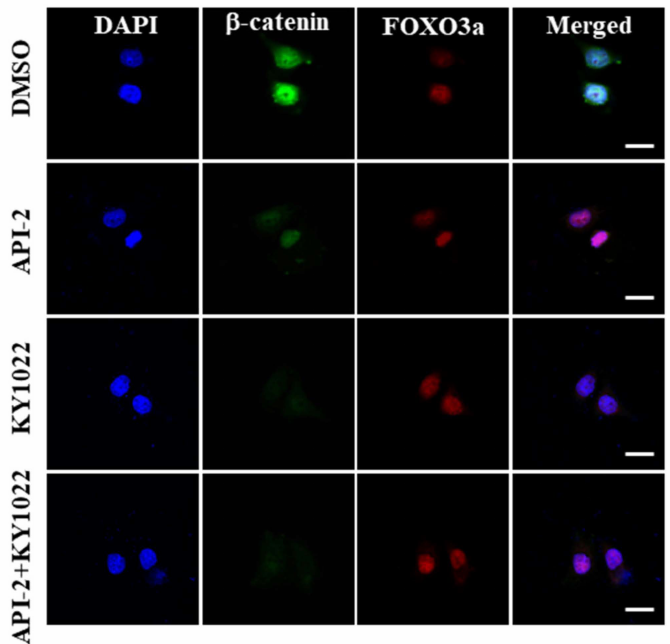
Figure 2. KY1022 destabilizes the nuclear β -catenin in the presence of API-2. The nuclear accumula- tion of β -catenin (green) and FOXO3a (red) were evaluated by immunocytochemical staining in LoVo cells, with treatment of API-2 (10 µ M), KY1022 (20 µ M), and the combination treatment. Nuclei were counterstained with DAPI. Representative images were captured using an LSM700 (Zeiss) confocal microscope ( n = 4 per group). Scale bars = 20 µ